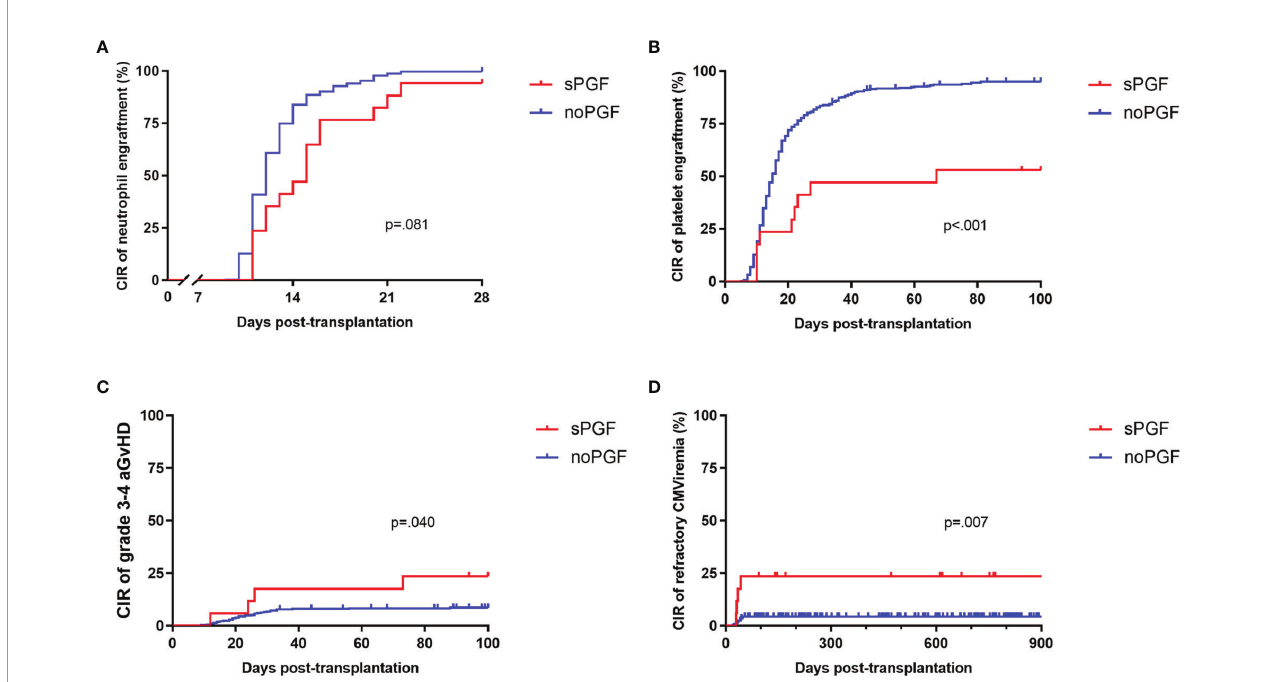
FIGURE 1 | The CIR of transplantation outcomes and complications in sPGF patients and noPGF patients: (A) 28-day neutrophil engraftment, (B) 100-day platelet engraftment, (C) grade 3-4 aGvHD, (D) refractory CMV viremia. Patients were censored when they were diagnosed with